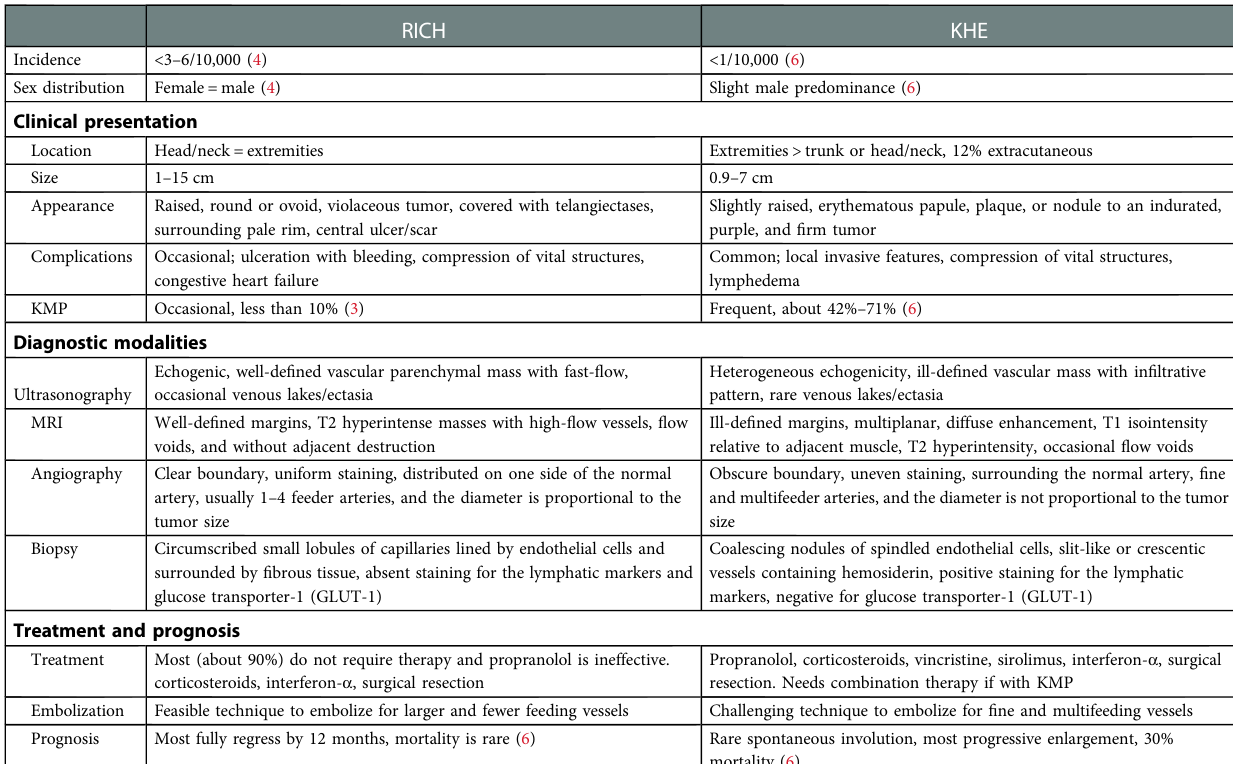
TABLE 1 Comparison of two common infantile vascular tumors associated with KMP (3 – 6,